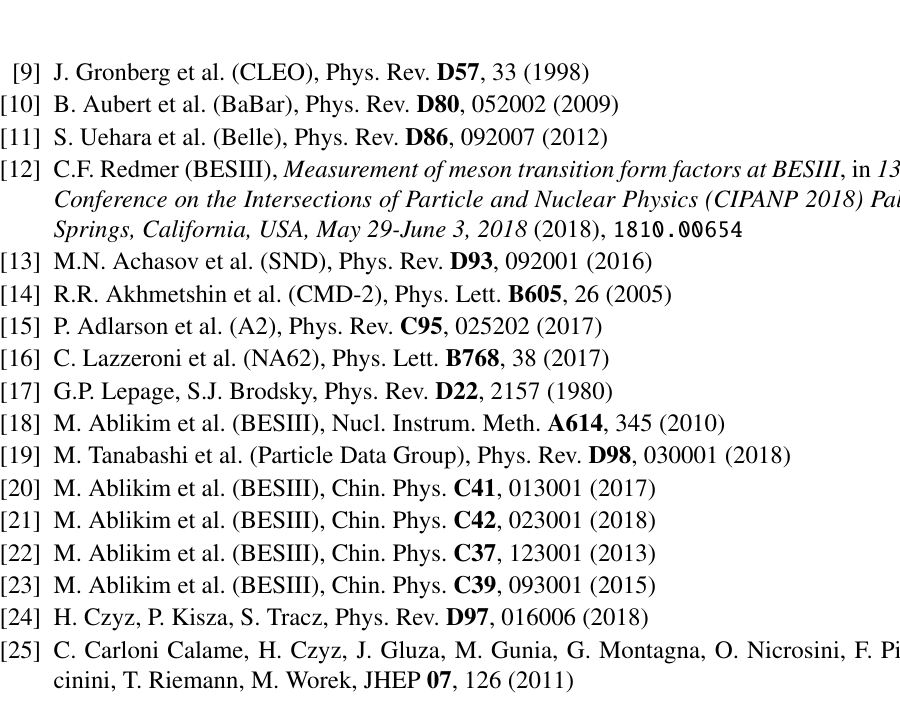
Figure 2. Measurements of the space-like π 0 TFF from BESIII (preliminary) [12], CELLO [8], CLEO [9], BaBar [10] and Belle [11] and the Brodsky-Lepage limit [17]. The red shaded area in- dicates the region of the time-like momentum transfer accessible at BESIII. The dashed error bars in- dicate the q 2 range and the expected statistically uncertainty of the combined data sets of this time-like measurement. The central value is chosen arbitrarily does not reflect the expected